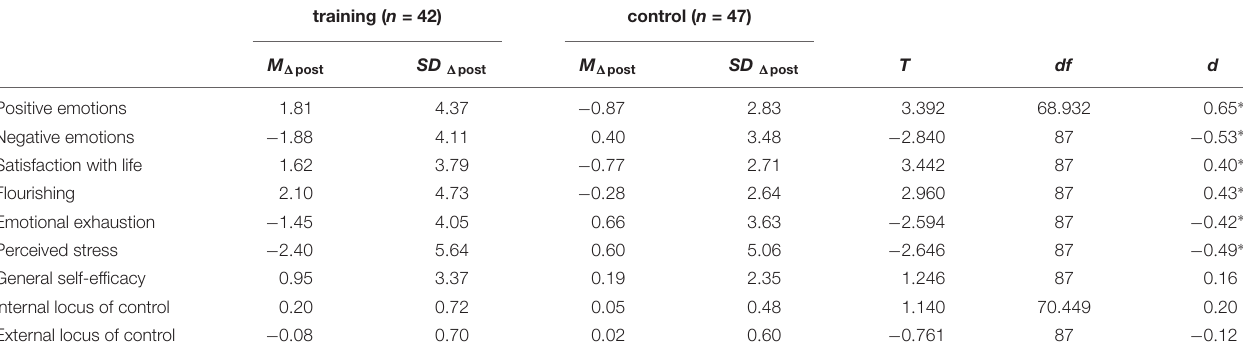
TABLE 4 | Between-group differences of within-group differences between t2 and t1 (pre–post). training ( n = 42) control ( n = 47) M (cid:49) post SD (cid:49)